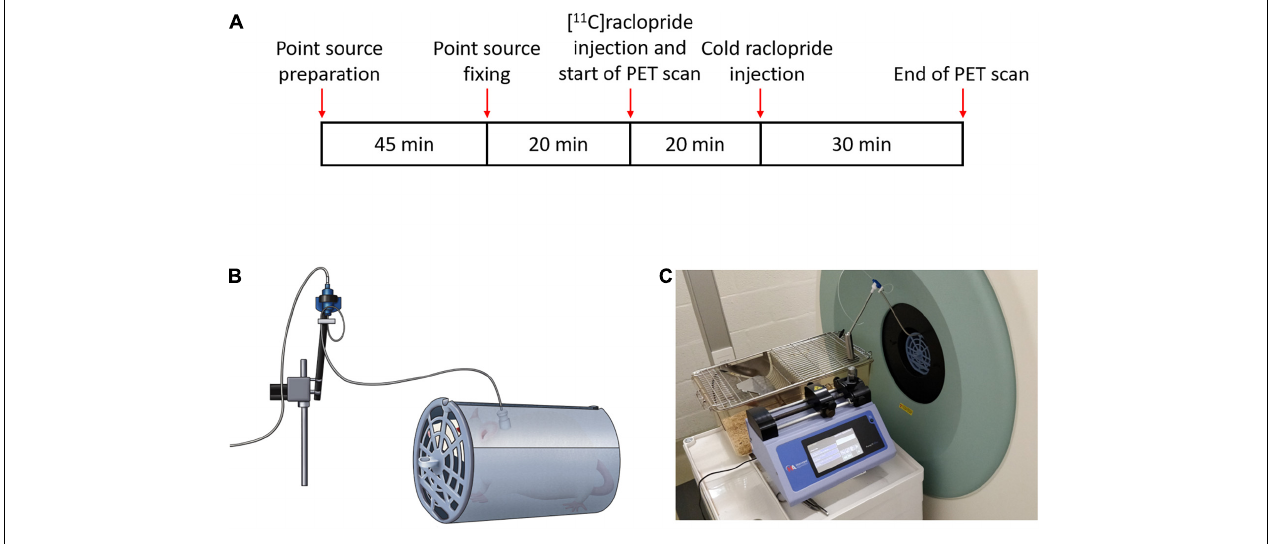
FIGURE 3 | (A) Scanning time schedules for the awake cold raclopride scan. (B) Diagram of the rat inside the holder tube connected to the line swivel and (C) scanner setup showing the injection pump and swivel.